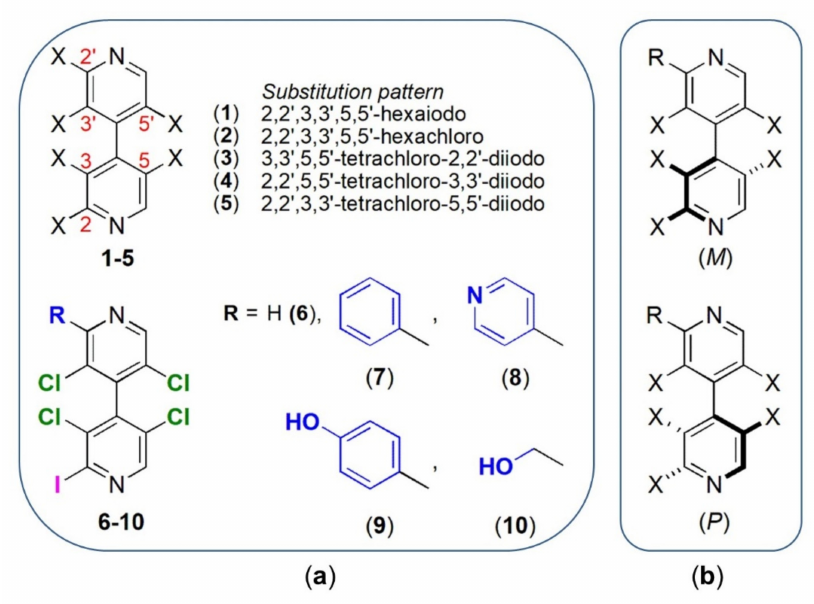
Figure 2. ( a ) Structures of halogenated 4,4 (cid:48) -bipyridines 1 – 10 ; ( b ) ( M ) and ( P ) absolute configurations of the atropisomeric 4,4 (cid:48) -bipyridines 1 – 5 and 7 – 10 .